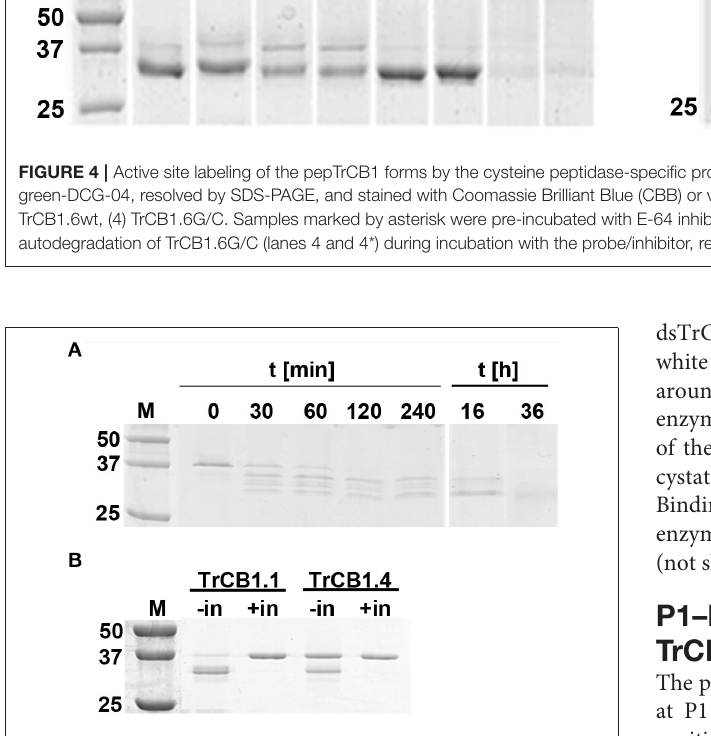
FIGURE 5 | Trans-processing of pro-TrCB1.6wt by IrAE, TrCB1.1, or TrCB1.4. (A) The pro-TrCB1.6wt was incubated at pH 5 with purified yeast medium containing activated IrAE for various time periods at 37 ◦ C. The TrCB1.6wt processing products were resolved by SDS-PAGE. (B) The TrCB1.6wt zymogen was incubated overnight at 37 ◦ C with pepTrCB1.1 or pepTrCB1.4 in the presence of dextran sulfate (10 µ g/ml). Processing of pro-TrCB1.6wt was visualized by SDS-PAGE, gel stained with Coomassie Brilliant Blue. Processing was inhibited with 10 µ M inhibitor of cysteine peptidases E-64. –/ + in denotes absence/presence of the inhibitor. M, markers of molecular size